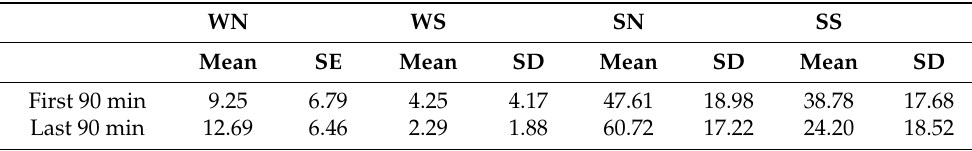
Table 5. Percentage of each actigraphy epoch